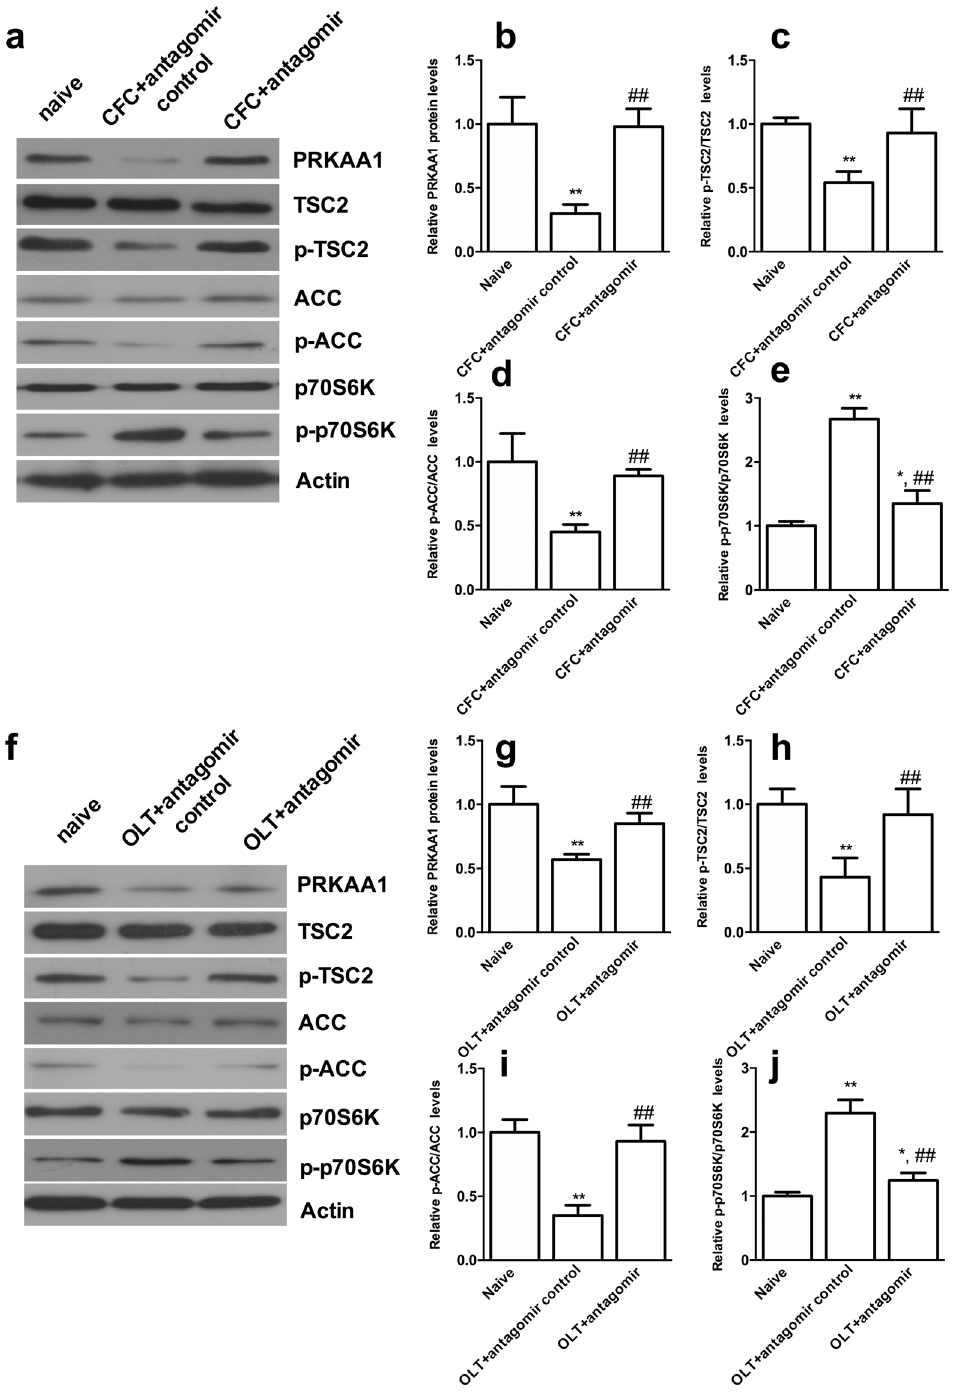
Figure 5. miR-181a was involved in LTM formation following CFC and OLT by regulating the expression and activity of PRKAA1. ( a ) Representative cropped western blots of PRKAA1, TSC2, p-TSC2, ACC, p-ACC, p70S6K and p-p70S6K protein levels in the mouse DH 2 h after CFC training. Original uncropped western blots are provided in a Supplementary Figure 1. ( b,e ) Statistical analysis of the western blot results. * p < 0.05, ** p < 0.01, compared with the naïve group. ## p < 0.01, compared with the CFC + antagomir control group. ( f ) Representative cropped western blots of PRKAA1, TSC2, p-TSC2, ACC, p-ACC, p70S6K and p-p70S6K protein levels in the mouse DH 2 h after OLT training. Original uncropped western blots are provided in a Supplementary Figure 2. ( b,e ) Statistical analysis of the western blot results. * p < 0.05, ** p < 0.01, compared with the naïve group. ## p < 0.01, compared with the OLT + antagomir control group. n = 5 per group. All values are presented as means ±